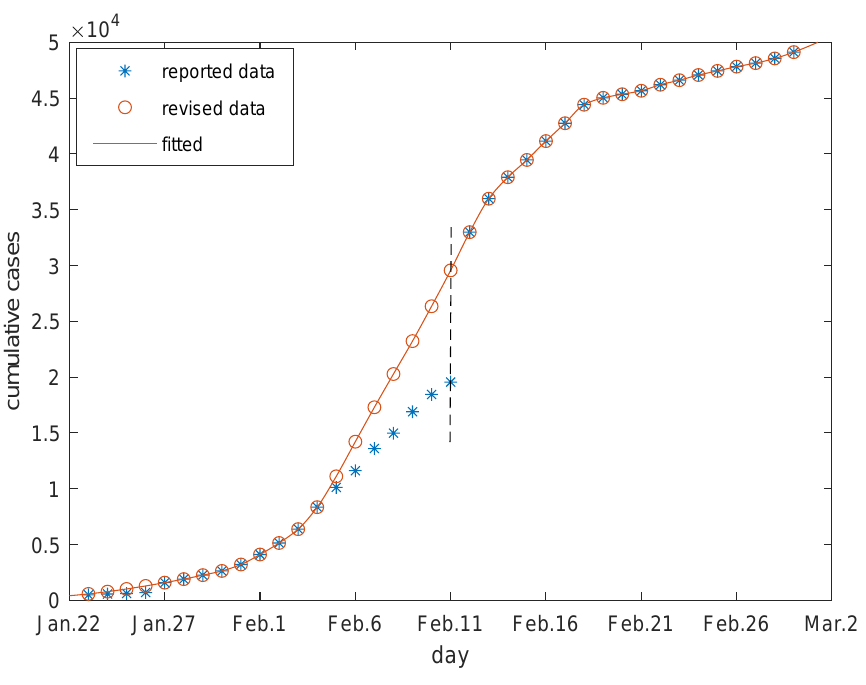
Figure 1. Data revision. Data from 23 January to 27 January and from 5 February to 11 February